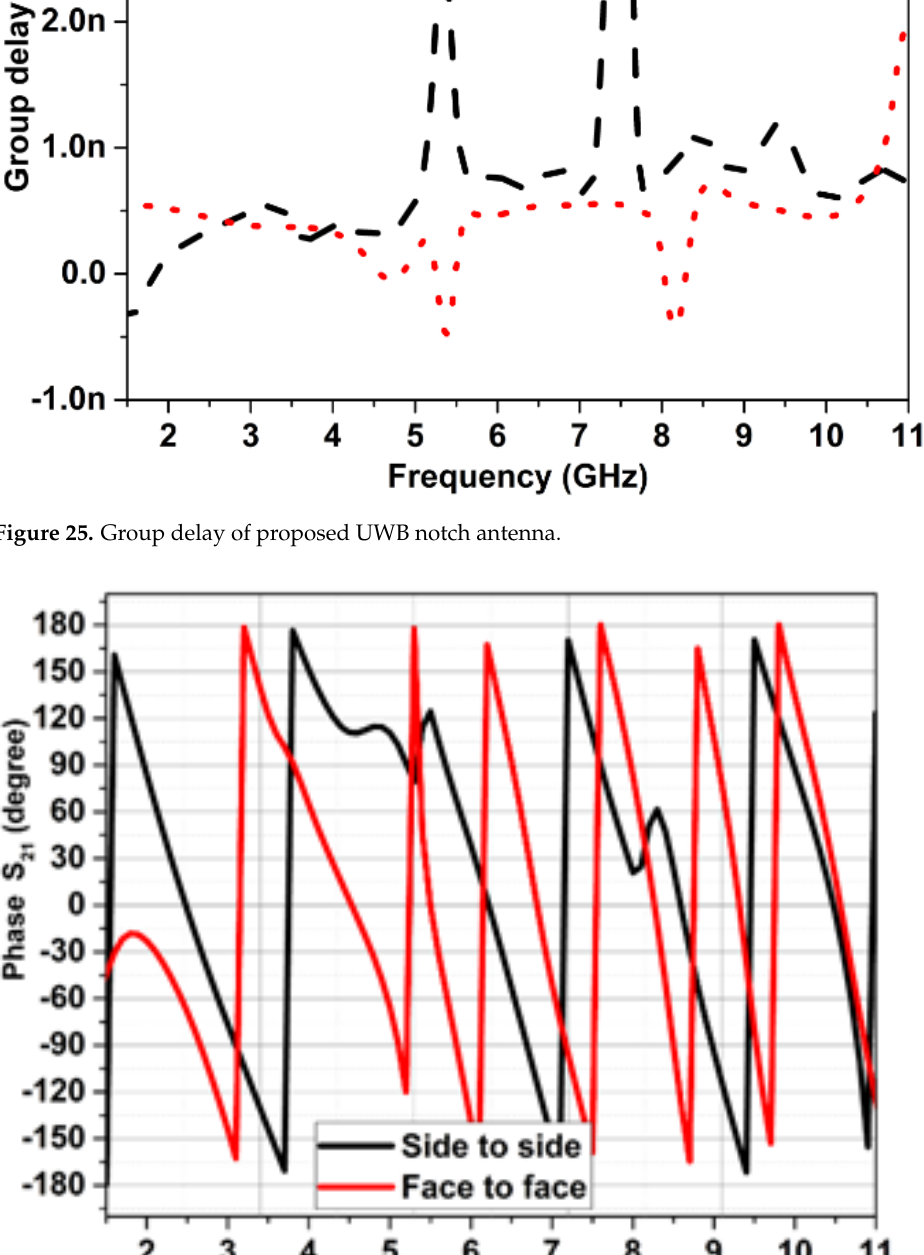
Figure 26. Phase response S 21 of the proposed UWB notch antenna.